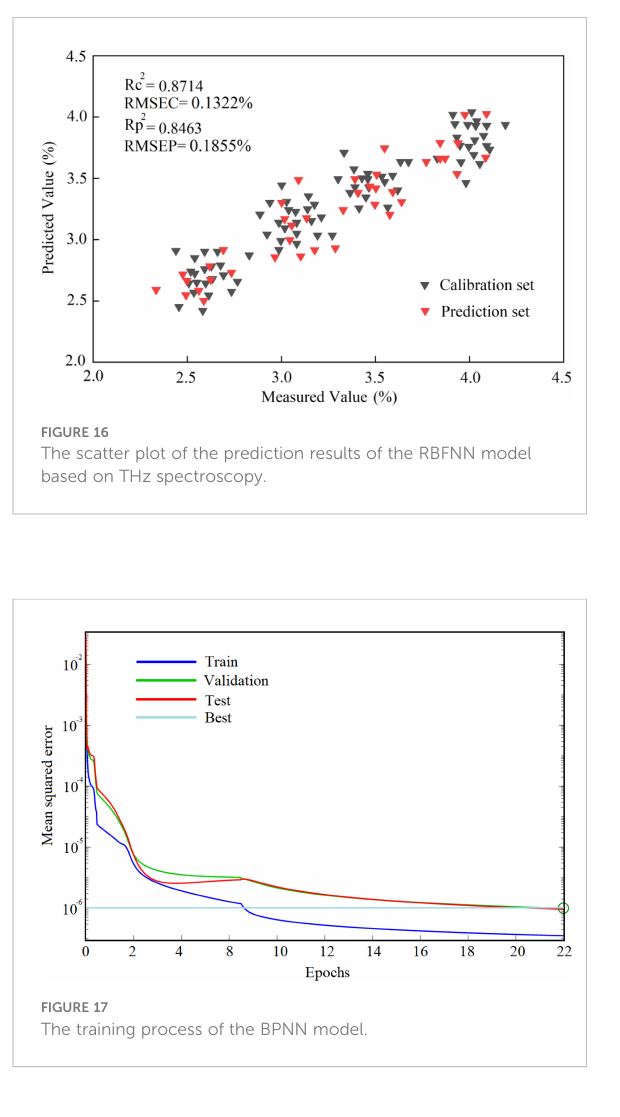
TABLE 4 The prediction results of the BPNN model based on THz spectroscopy. Algorithm for band screening